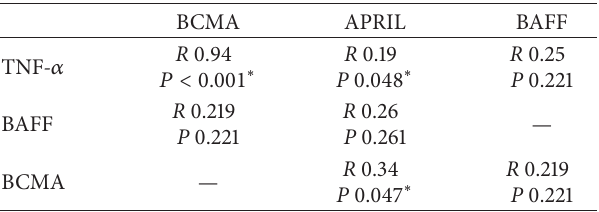
Table 3: Correlations of TNF- 𝛼 , APRIL, BCMA, and BAFF within the patients’